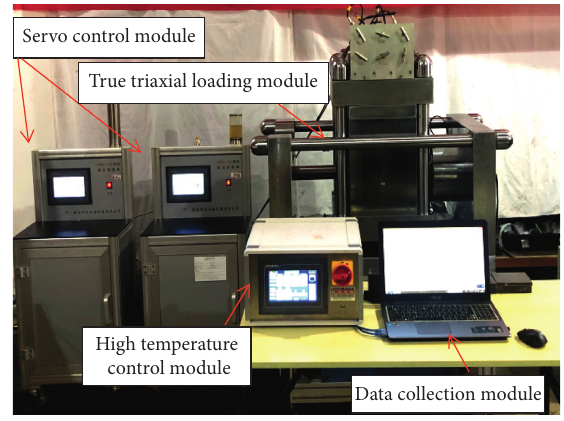
Figure 1: Photo of real-time high-temperature true triaxial test